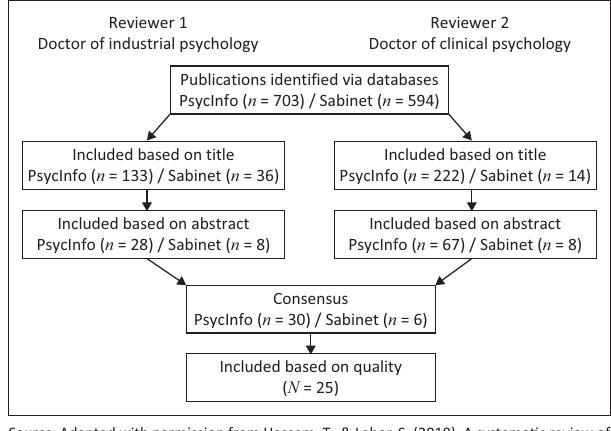
FIGURE 1: Flow diagram of articles that were included and